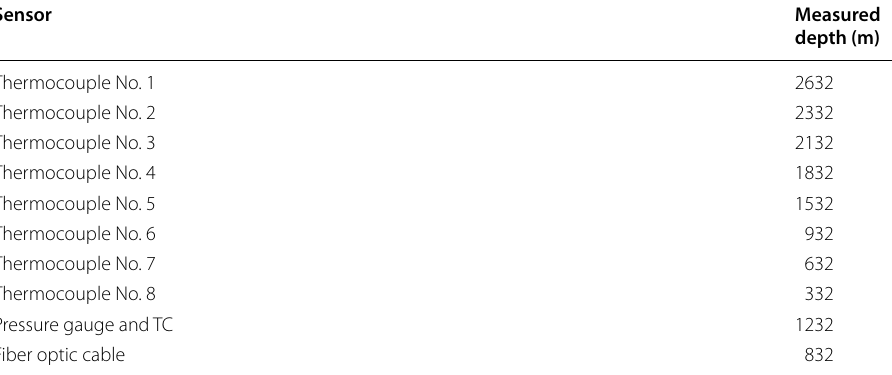
Table 1 List of downhole sensors installed in RN-15/DEEPEGS/IDDP-2 with depth reference to surface